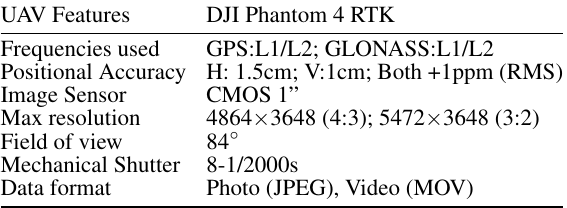
Table 1. Da-Jiang Innovations Science & Technology Co. Ltd (DJI) Real Time Kinematic (RTK) of Phantom 4 Specifications according to (Phantom, 2018).